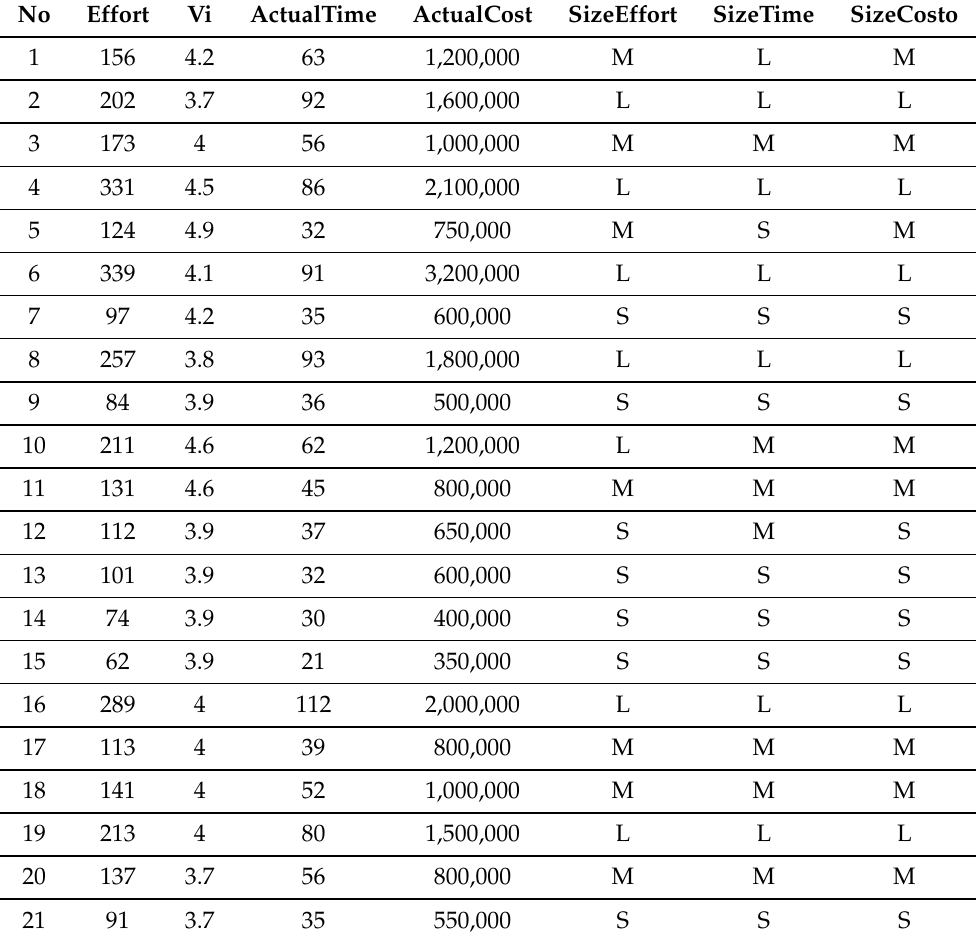
Table 6. Reduced dataset with category size labels, where ActualTime and ActualCost are the columns to predict and the rest columns are the input